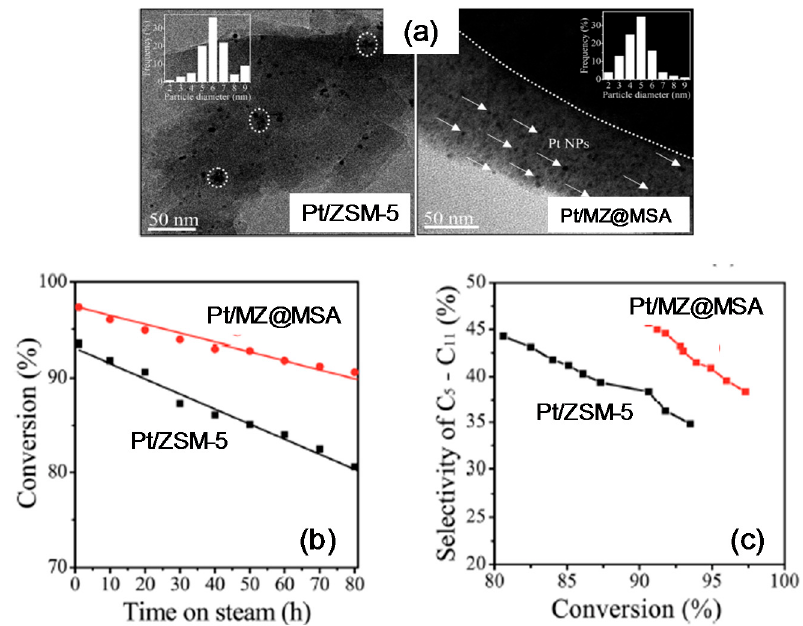
Figure 16. ( a ) HRTEM images of Pt/ZSM-5 and Pt/MZ@MSA catalysts; the insets depict the size distribution of Pt nanoparticles (NPs); ( b ) The conversion of n-hexadecane with time-on-stream and ( c ) the selectivity to C 5 –C 10 hydrocarbons as a function of the conversion in the hydrocracking of n-hexadecane over Pt/ZSM-5 and Pt/MZ@MSA catalysts. Adapted with permission from [68].